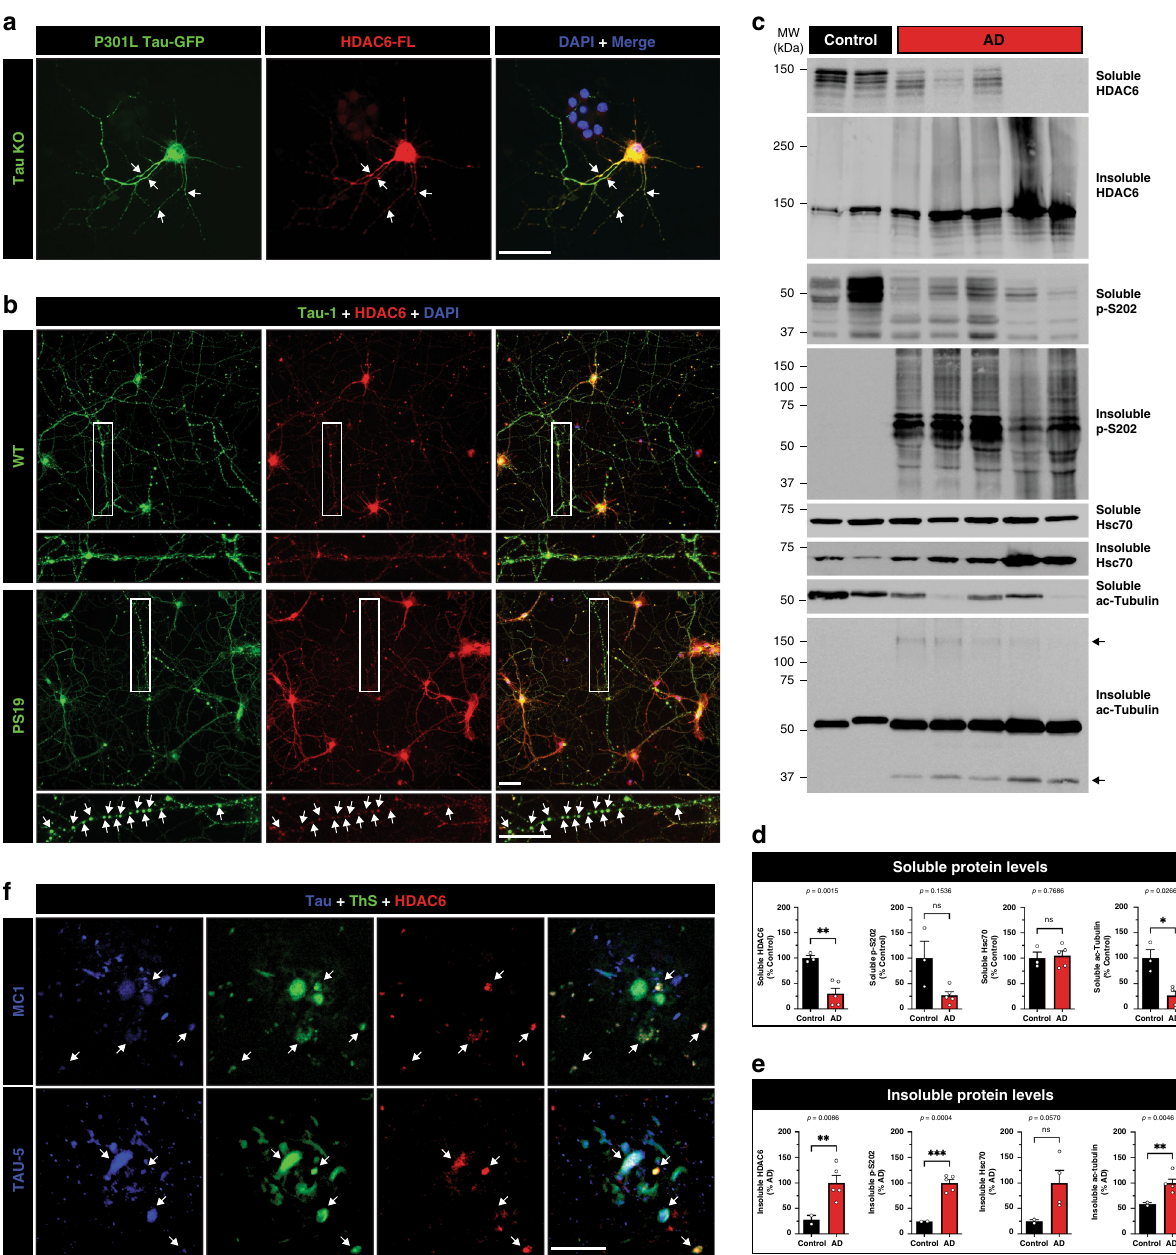
Fig. 2 HDAC6 co-aggregates with tau and accumulates in pathological tau lesions. a Primary cortical neurons from mouse embryos (E16) of tau knockout (KO) mice were cultured for 10 days in vitro (10 DIV) and transfected with P301L Tau-GFP (green) and HDAC6-FLAG (FL) (red) expression constructs followed by imaging. Arrows indicate regions of extensive co-localization along processes. Scale bar = 50 μ m. b Primary cortical neurons (E16) from WT (top) and PS19 tau transgenic (bottom) mice were analyzed by immuno fl uorescence (IF), detecting co-localized focal swellings of tau (green), endogenous HDAC6 (red), and the nuclei marked by DAPI (blue). The white rectangle highlights a magni fi ed insert of a neuronal process harboring tau- positive foci. Scale bar = 50 μ m. c Biochemical fractionation of soluble high-salt fractions and insoluble urea fractions were extracted from frontal cortex of control and AD brains followed by immunoblotting to detect HDAC6, tau, Hsc70, and acetylated tubulin. The arrows highlight acetylated tubulin fragments ~37 kDa and higher molecular weight species ~150 kDa. d , e Immunoblotting results were quanti fi ed by densitometry. f AD cortical sections were analyzed by double-labeling IF using either conformational tau (MC1) or total tau (TAU-5) antibodies (blue), combined with Thio fl avin S (ThS) (green), and HDAC6 (red) to evaluate localization in proximity to AD neuritic plaques. White arrows highlight regions of tau and HDAC6 immunoreactivity that are associated with ThS positive plaques. Scale bar = 50 μ m. Statistical tests: p value determined by two-sided unpaired t -test with Welch ’ s correction from n = 5 biologically independent samples ( d , e ). Representative neurons are shown from n = 3 biologically independent experiments ( a , b ) and n = 3 independent AD brains ( f ). Error bars represent means ± SEM and are plotted relative to control ( d ) or relative to AD ( e ). * p < 0.05, ** p < 0.01, *** p < 0.001. Source data are provided as a Source Data fi